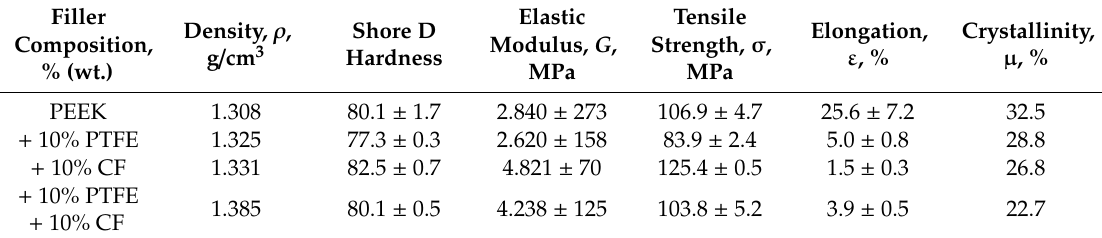
Table 2. Mechanical properties of the PEEK and PEEK-based composites.